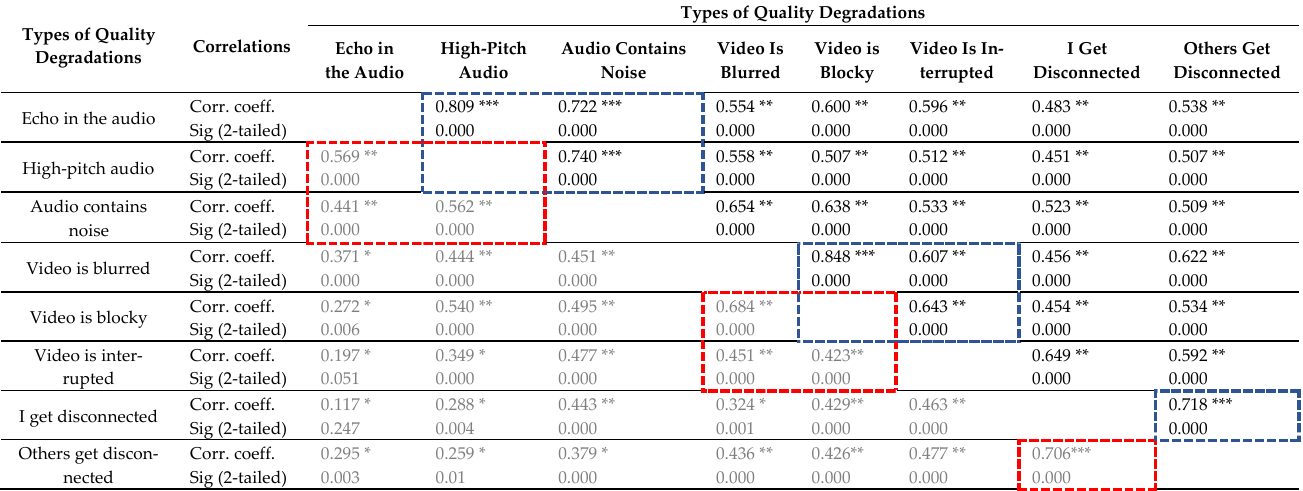
Table 8. The correlation between the levels of frustration and degradation frequency for a pair of quality degradations. Types of Quality